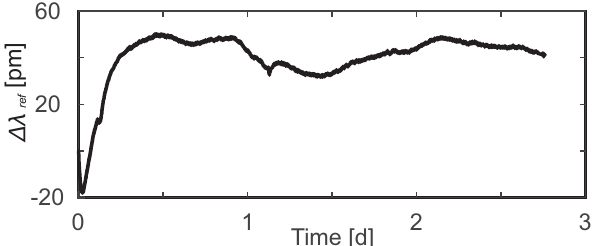
Figure 4. The long-term wavelength drift of the FBG interrogator at 1550 nm as measured with a temperature-controlled FBG